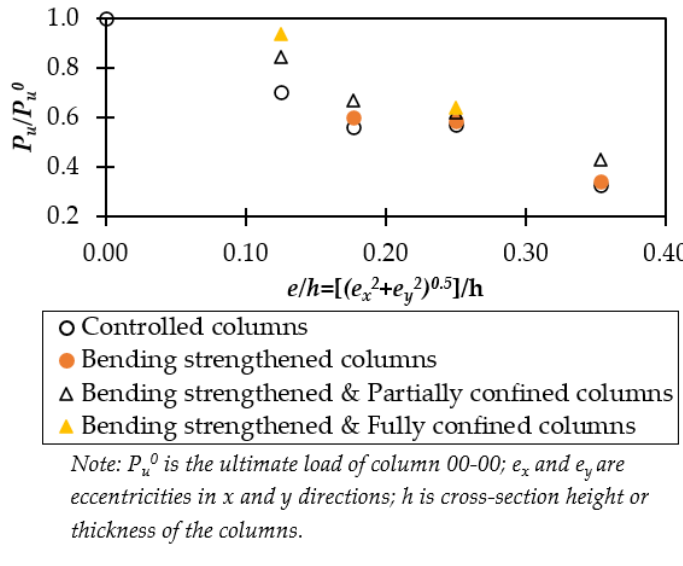
Figure 11. Strength reduction regarding e/h